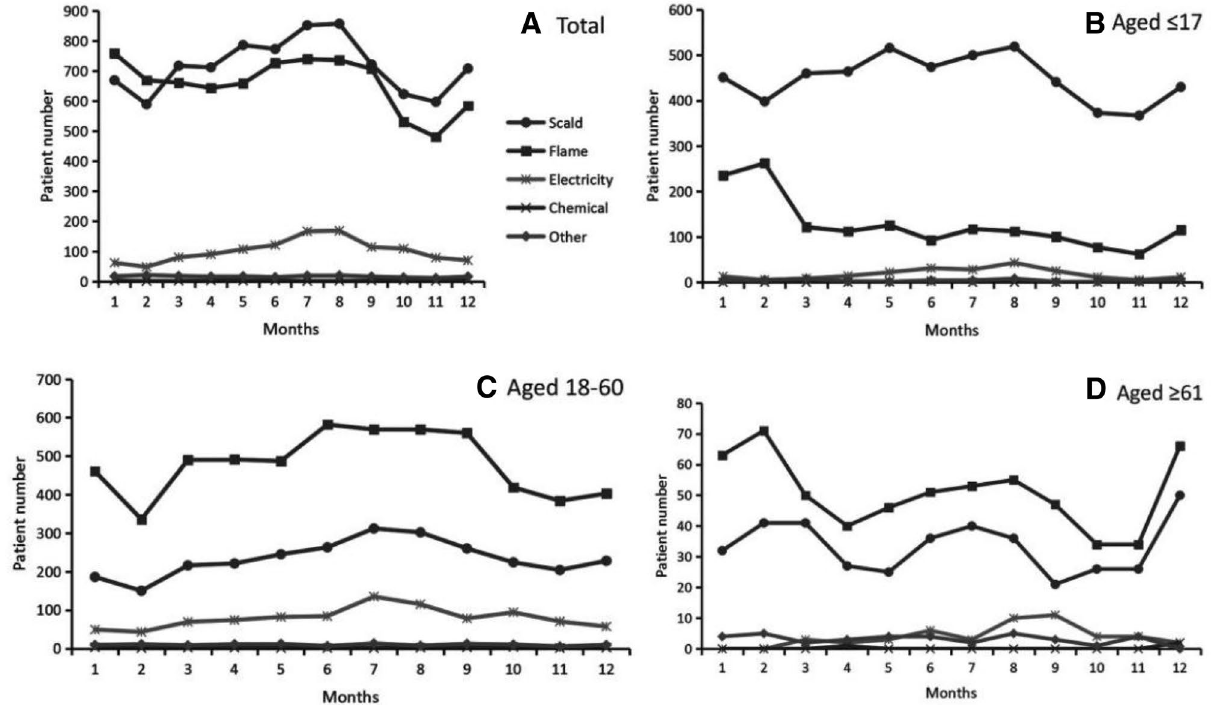
Figure 2. Distribution of burn causes by months in different age groups. ( A ) In total patients. ( B ) In patients under the age of 18 years old. ( C ) In patients aged between 18 and 60 years old. ( D ) In patients above the age of 60 years old.